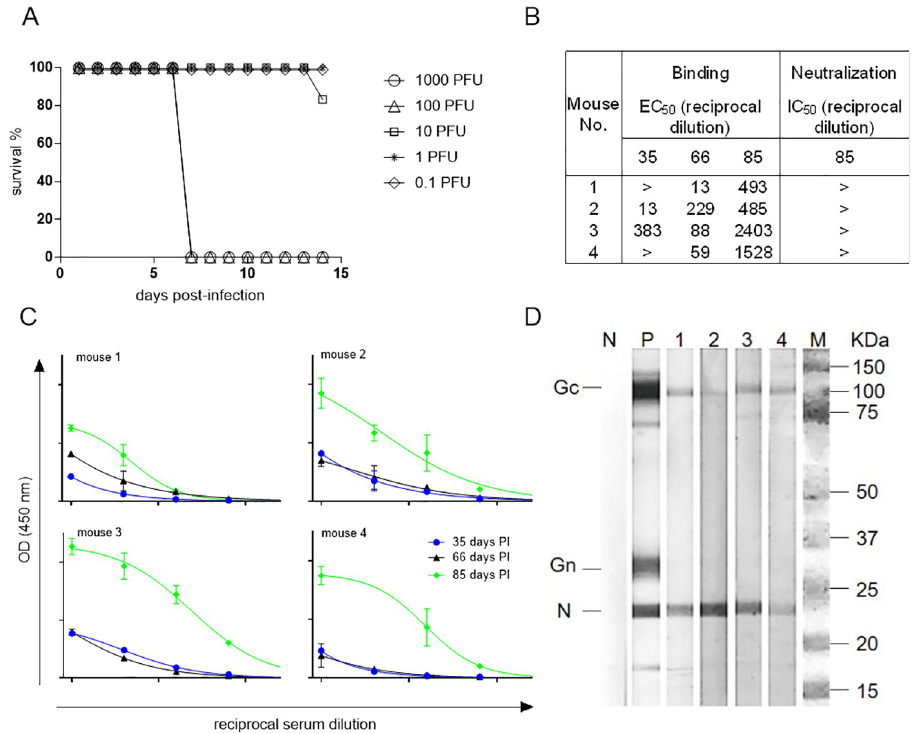
Fig 1. Virulence of CVV and anti-CVV specific Ab response in AG129 mice. A) Mice (n = 6/group) were inoculated IP as described with 10-fold dilutions of CVV and monitored for signs of morbidity. 1000 PFU (open circle), 100 PFU (open triangle), 10 PFU (open square), 1 PFU (star), and 0.1 PFU (open diamond). B) and C) Binding of anti-CVV Ab from immunized mice to purified virus was determined by indirect ELISA with 4-fold dilutions of sera. Colors indicate day PI (day 35 (blue), day 66 (black), day 85 (green)). EC 50 values, shown as the reciprocal of dilution of sera, were determined by non-linear fit analysis, with the bottom of the curve constrained to 0, using GraphPad Prism software V6. EC 50 values were calculated for 35-, 66- and 85-days PI. IC 50 values for 85-days PI were determined by non-linear fit analysis, with the bottom and top of the curve constrained to 0 and 100, respectively, using GraphPad Prim software V6. > indicates no detectable binding reactivity or neutralizing activity at a 1:10 dilution of sera. D) CVV protein- specific Ab responses in AG129 mice 85-days PI. Lanes: N (negative control (PBS)), P (positive control (CVV MHIAF)), 1 (mouse 1), 2 (mouse 2), 3 (mouse 3), 4 (mouse 4), M (Bio-Rad Precision Plus Protein Dual Color Standard (Cat# 1610374)), Gc (glycoprotein C), Gn (glycoprotein N), N (nucleoprotein), kDa